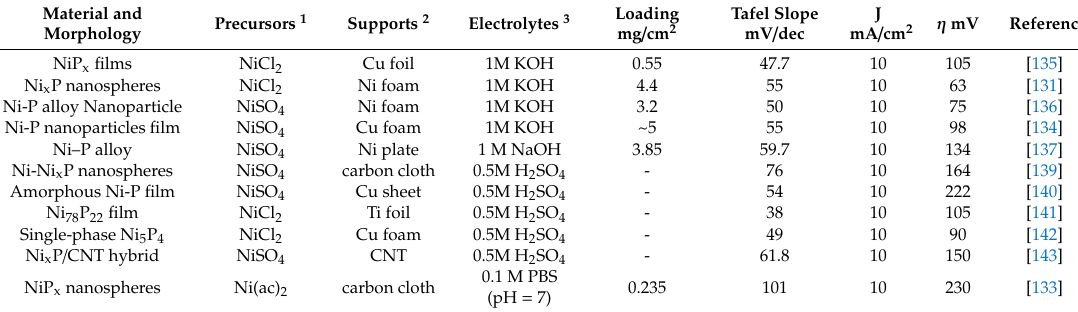
Table 8. Summary of the nickel phosphide electrocatalysts prepared through electrochemical deposition for